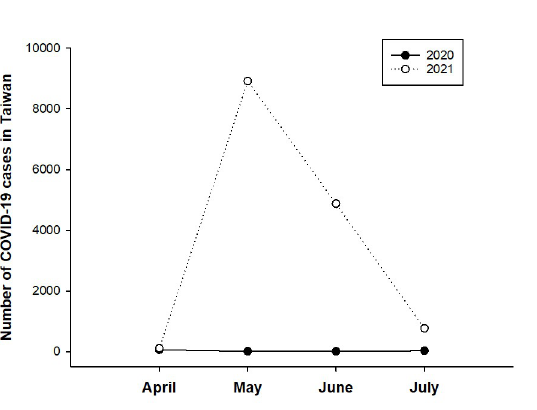
Fig 1. Numbers of newly diagnosed COVID-19 cases in Taiwan from April to July 2020 and 2021. COVID-19: coronavirus disease 2019.